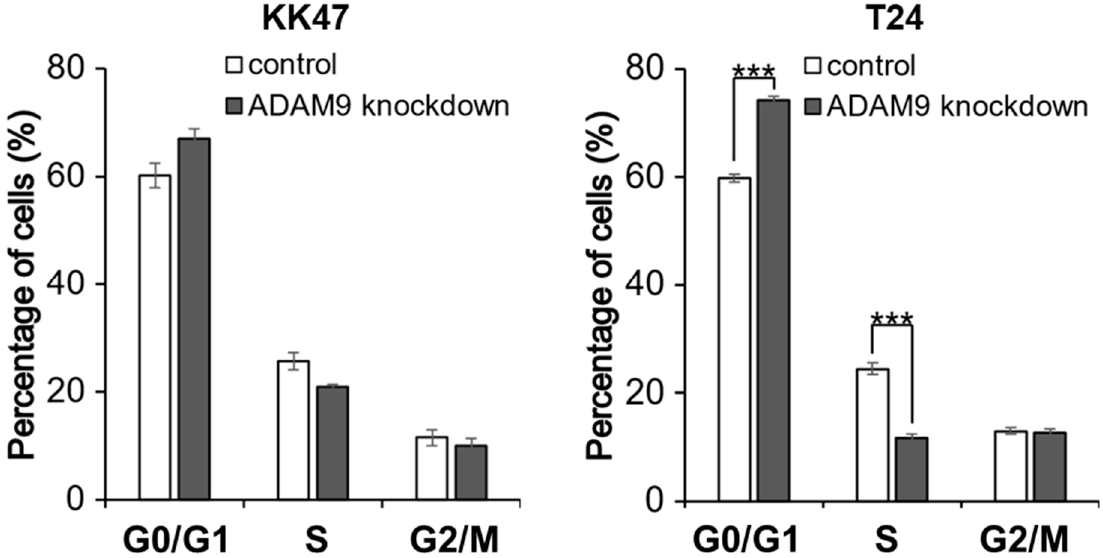
Figure 3. Percentage of cells in each phase. The effects of ADAM9 on cell cycle in KK47 and T24 cells were measured by flow cytometry using Cell Cycle Assay Solution Blue. The percentage of cells in each cycle was investigated in control and ADAM9 knockdown KK47and T24 cell lines. KK47 cells showed no significant difference between control and ADAM9 knockdown, while in T24 cells, G0/G1 phase were increased by ADAM9 knockdown and S phase cells decreased compared with control ( p < 0.001) (*** p < 0.001).